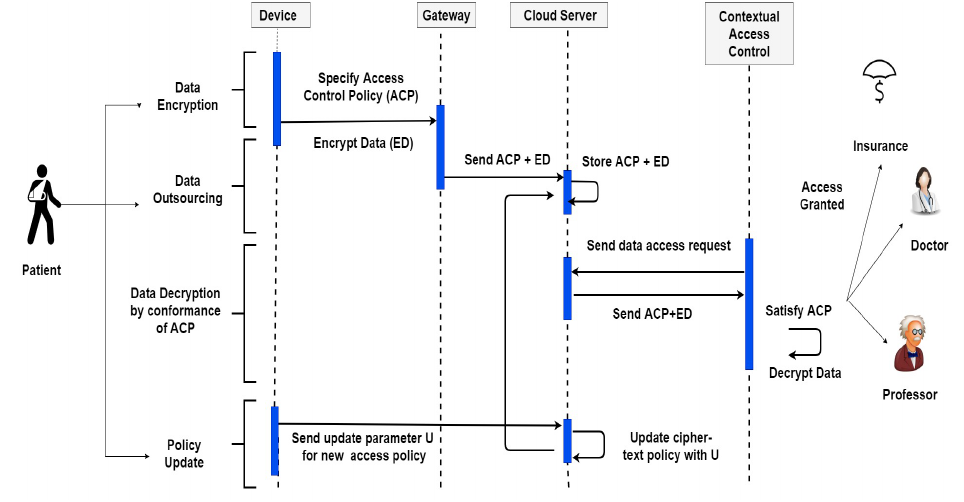
Figure 2. Flow Diagram of Access Control